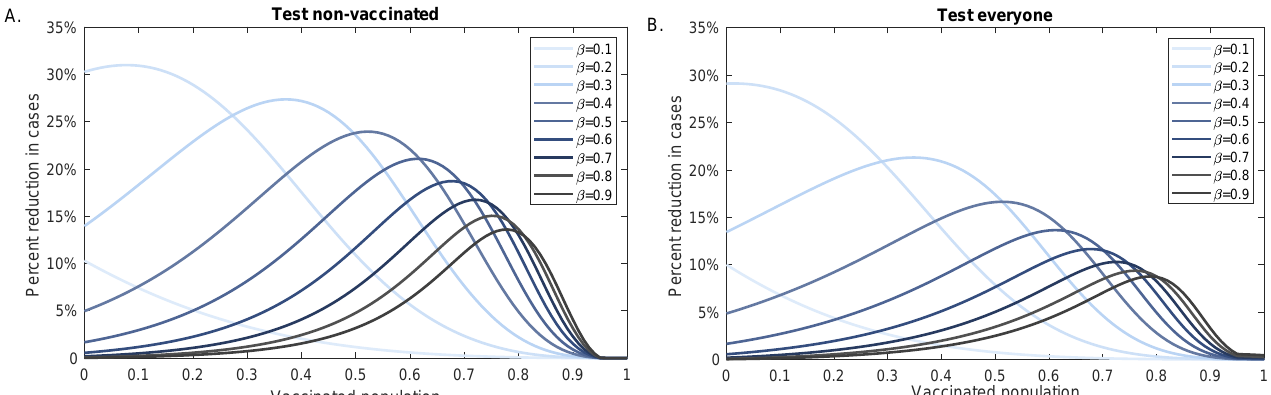
Figure 6. Percent reduction in variant cases at 100 days as vaccination increases. Percent reduction in cumulative cases at 100 days after an outbreak with a variants of different infectivity rate β , ( Σ noTests ( 100 ) − Σ Tests ( 100 )) / Σ noTests ( 100 ) , as given by model Equation (1) versus background vaccination levels, V 0 . Panel ( A ): Test non-vaccinated only; Panel ( B ): Test everybody. Parameters and initial conditions are given in Table 1 and we assume RT-PCR testing capacity C = 0.1 with a return delay of 1 day.